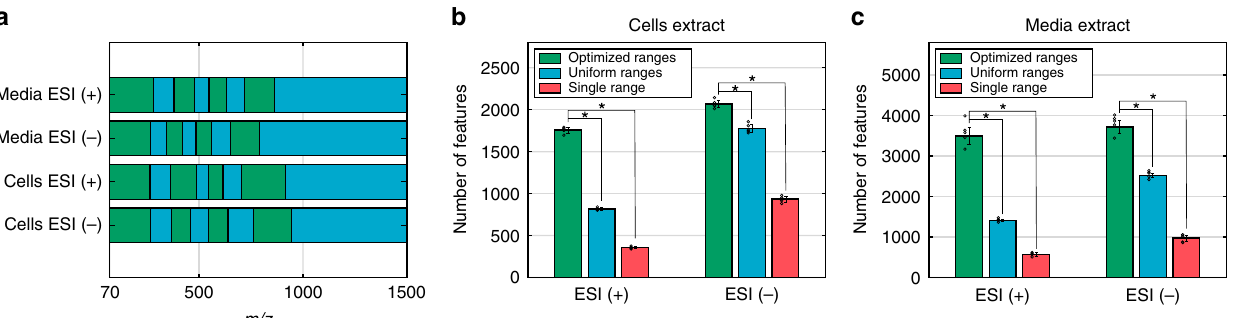
Fig. 4 FI-MS-based metabolomics with optimized scan ranges applied for cultured cancer cells. a The optimized eight scan ranges for metabolomics FI- MS-based analysis of metabolite extracts from cancer cells and from culture media in positive and negative ionization modes. The number of reproducible m/z features observed when utilizing the eight optimized scan ranges (in green), compared with eight uniform scan ranges (in blue), and a single scan range (in red), analyzing metabolite extracts from cancer cell ( b ) and from culture medium ( c ). * p < 10 − 5 by two-sample two-sided t -test. Data are mean values ± SD, n = 5 independent repetitions of the FI-MS analysis. Source data are provided as a Source data than that for uniform range FI-MS ( r = 0.87, FDR corrected p value < 0.05) and single range FI-MS ( r = 0.78, FDR corrected p value > 0.05).